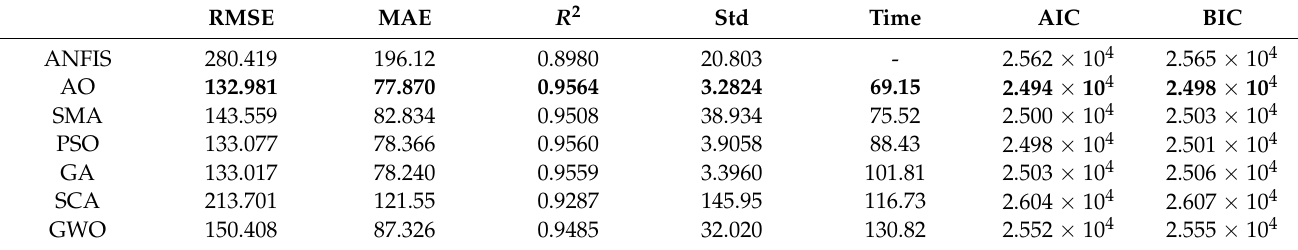
Table 2. The results of the Almasila oilfield, Yemen. The best values are shown in